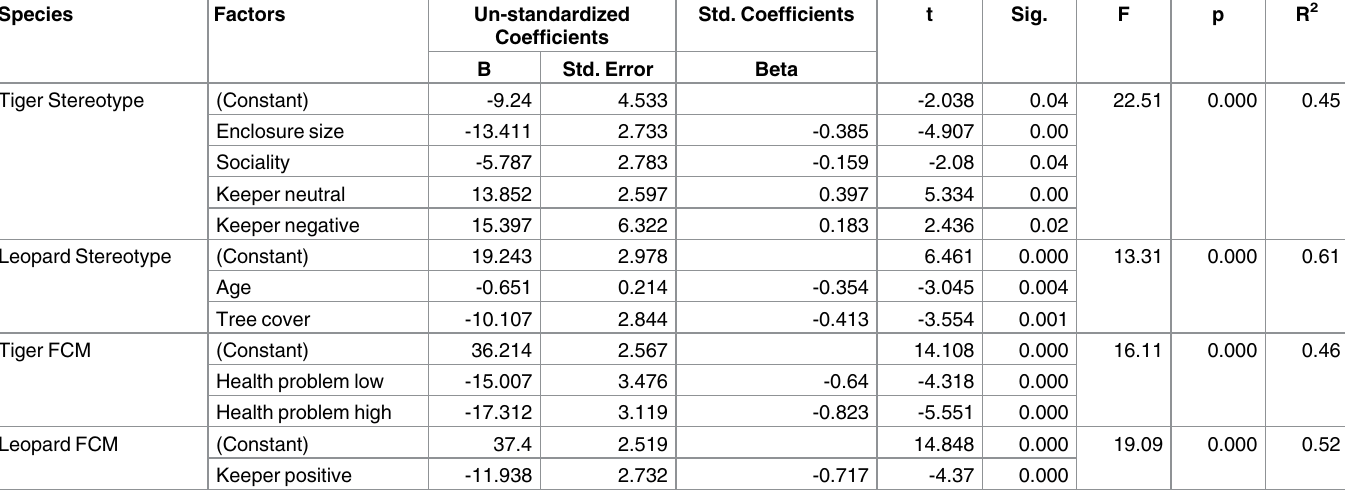
Table 7. Regression equation model to explore the effect of biological and environmental factors on the intensity of stereotype and FCM level among tigers and leopards at six Indian zoos. Species